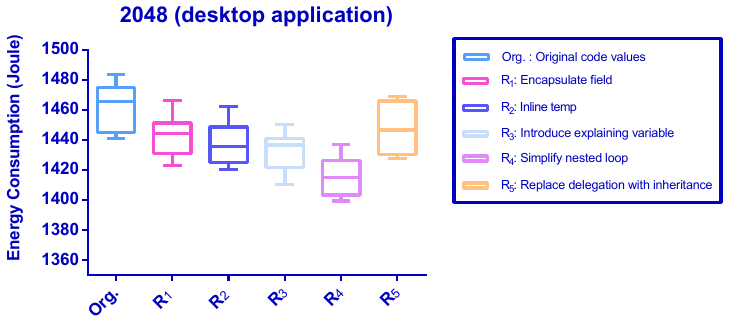
Figure 3. Boxplot of energy consumption results of the original and refactored codes for the laptop dataset. The x axis represents the name of each dataset and the y axis represents the energy consumption. 2048 (mobile application)